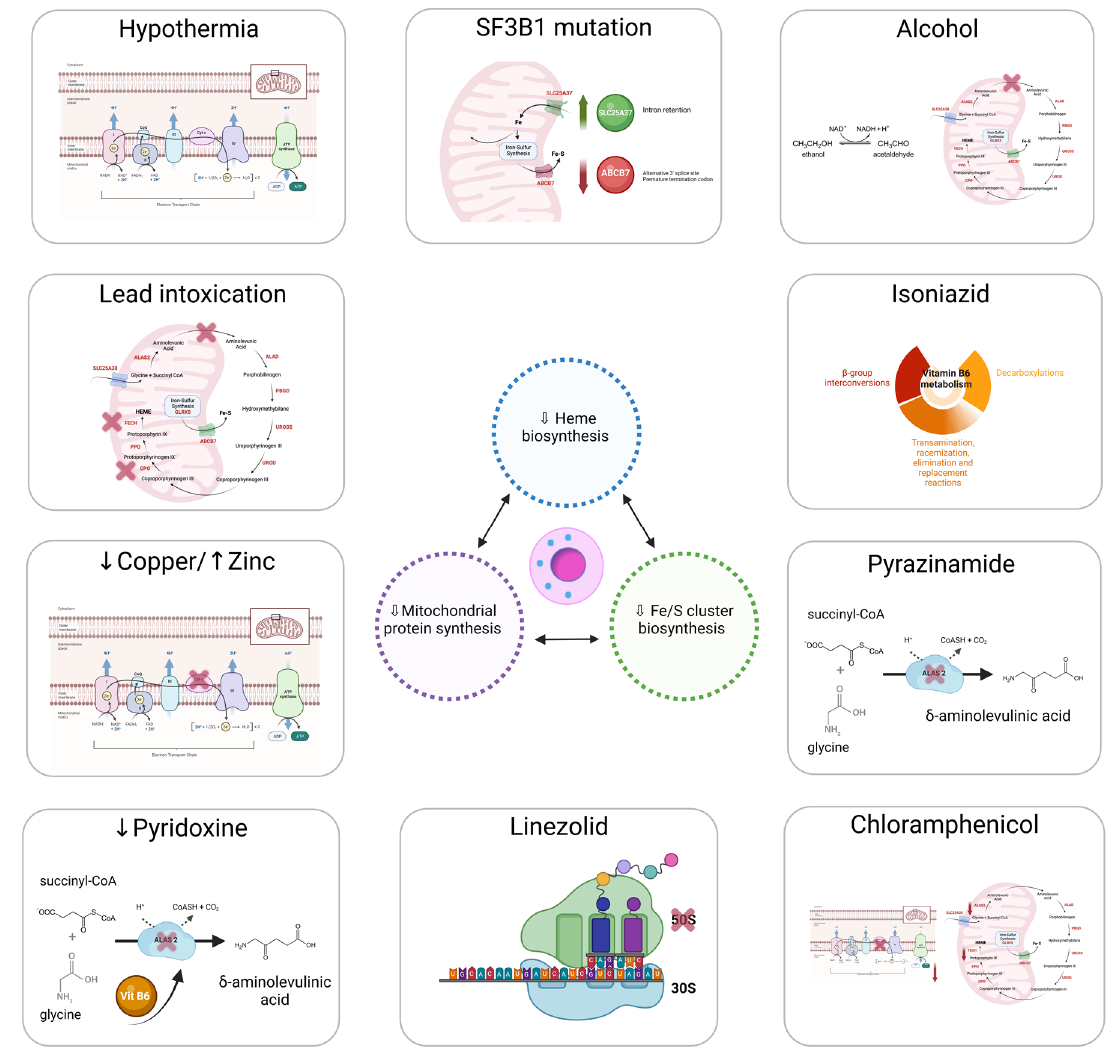
Figure 1. Main causes of acquired sideroblastic anemia. Mitochondria provide the majority of the ATP needed by eukaryotic cells through oxidative phosphorylation [13]. The adult erythrocyte is the only mammalian cell that does not have mitochondria, relying exclusively on anaerobic glycolysis for ATP production [14]. Mitochondria are semi-autonomous organelles that most likely evolved from free-floating prokaryotes that infiltrated eukaryotic cells over a billion years ago